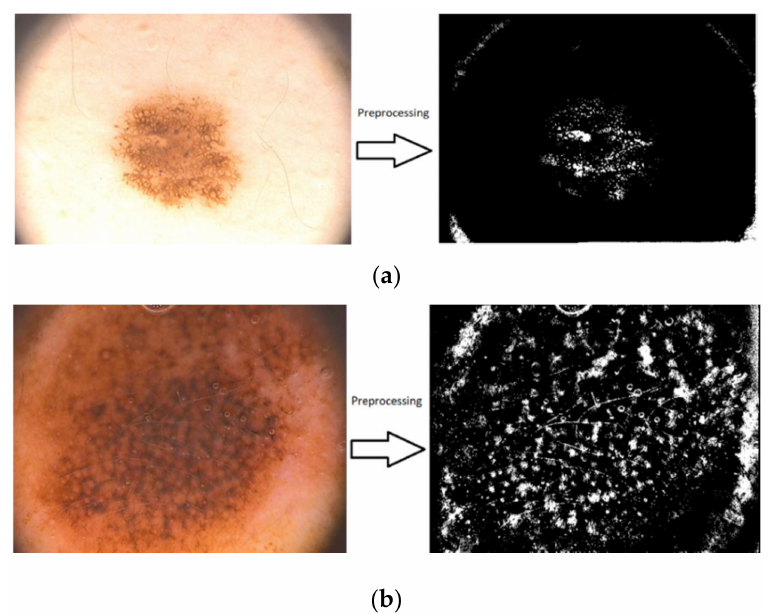
Figure 28. Sample images showing the results of preprocessing component: ( a ) common nevus and ( b ) melanoma.